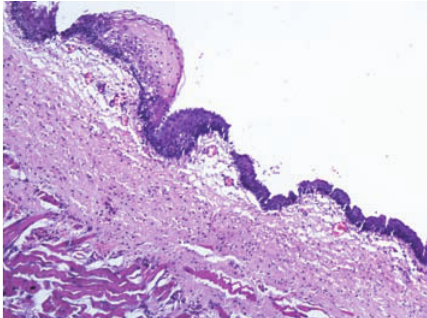
Figure 2: MRI scan: midline sagittal fat suppressed T2 weighted image showing the cystic lesion above the mylohyoid with no extension.